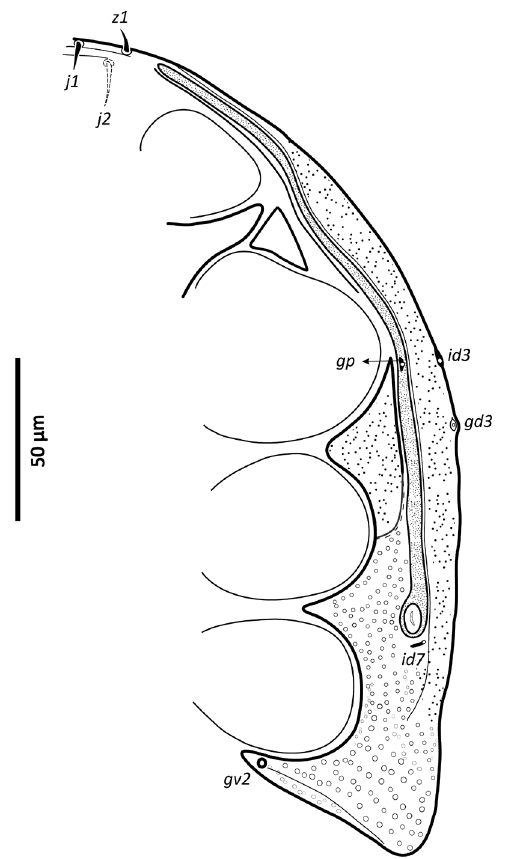
Figure 19. Zygoseius lindquisti sp. n., female, peritrematal shield. and an oval platelet bearing two pore-like structures, at level of posterior margin of peritrematal